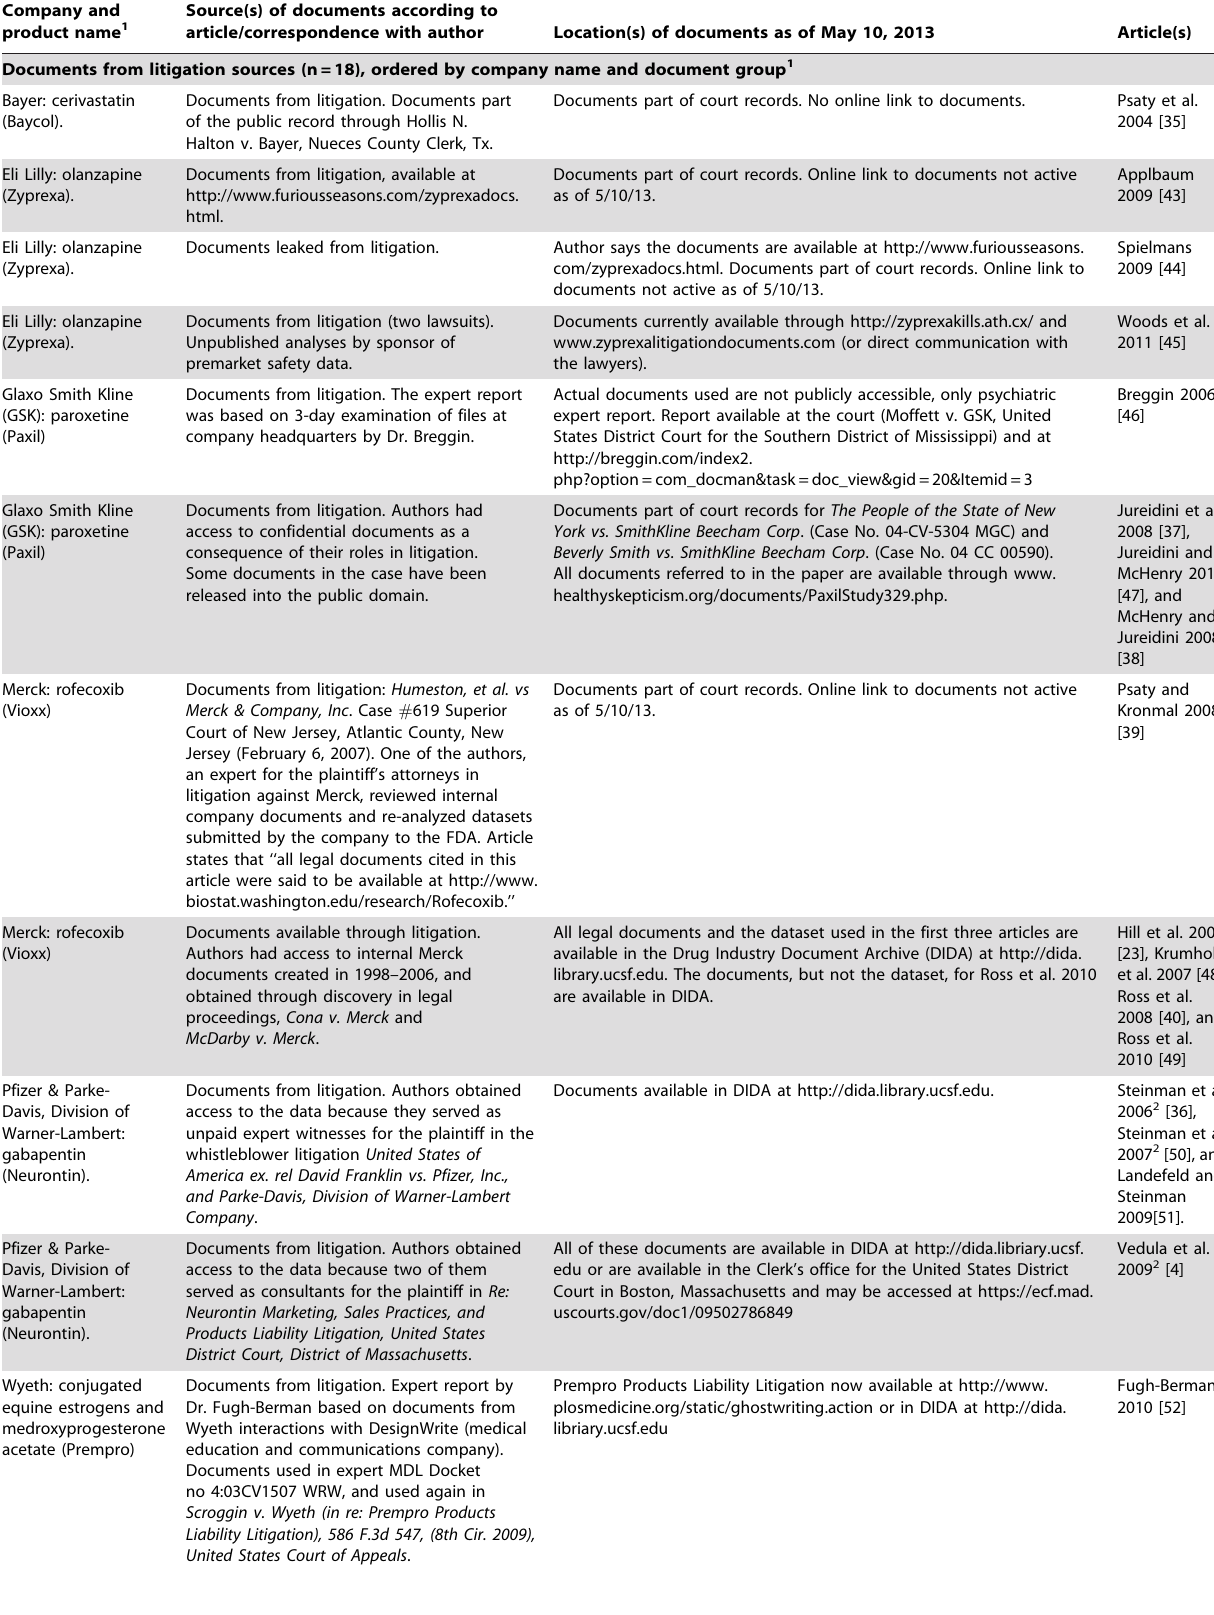
Table 4. Sources and location of pharmaceutical internal company